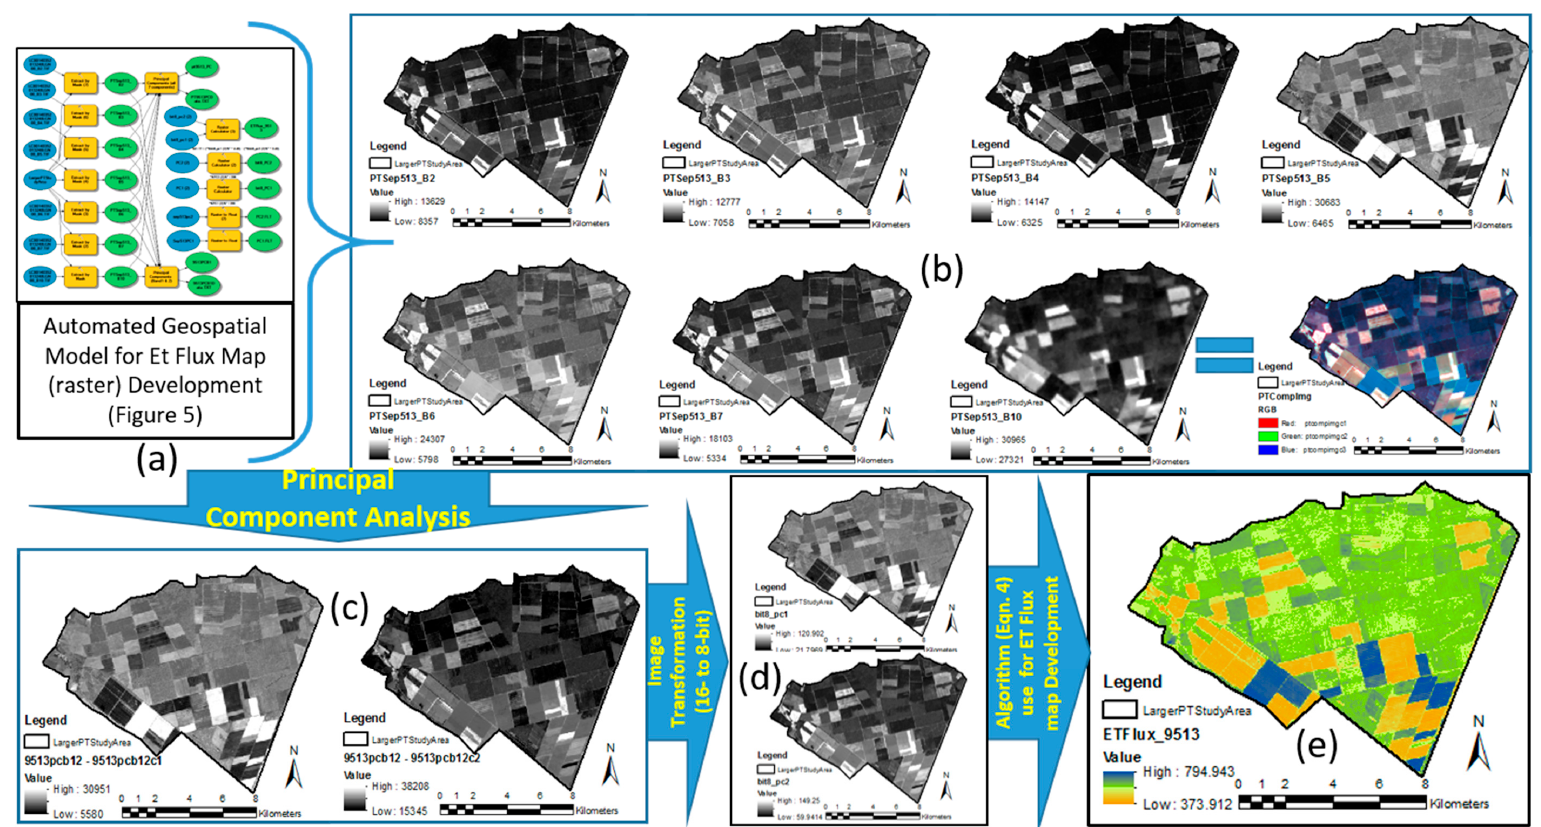
Figure 7. Resultant maps of the entire step-by-step process of the study to develop the automated geospatial model in ArcGIS ModelBuilder to develop the ET flux map of the study area using Landsat image rasters: ( a ) Automated geospatial model for ET Flux raster development using remote sensing data; ( b ) individual band raster of a selected composite Landsat 8 image; ( c ) 16-bit principal component 1 and 2 rasters obtained from the PCA analysis of the composite image; ( d ) 8-bit converted PC1 and 2 raster from Landsat 8 imagery 16-bit raster to compliment with 8-bit Landsat 7 ETM+ PC rasters; ( e ) Equation (8) based ET Flux raster of the study area.